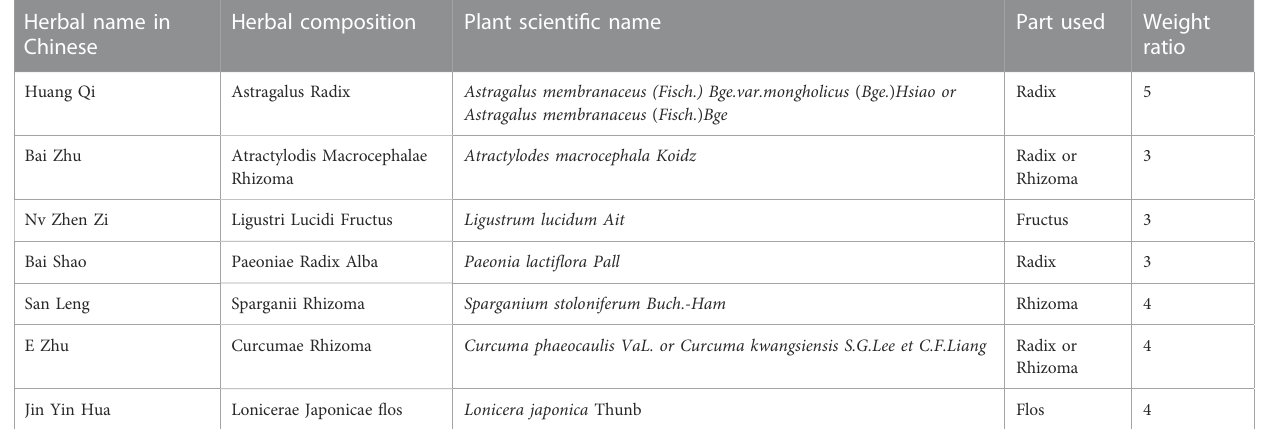
TABLE 1 Composition of